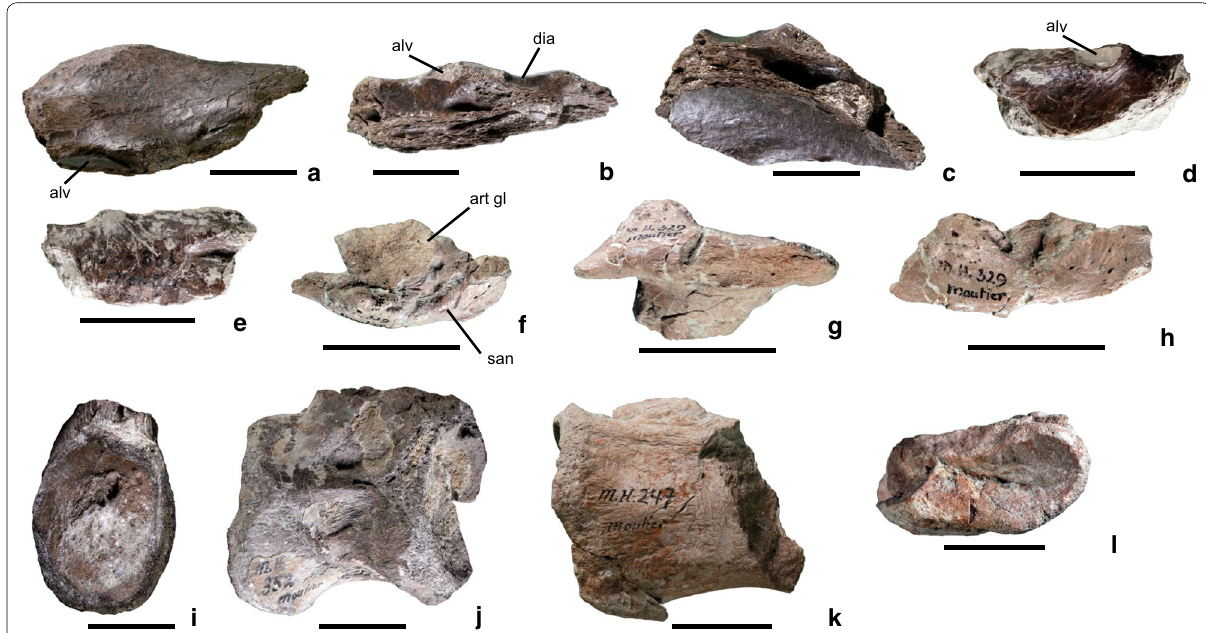
Fig. 16 Bone fragments of teleosaurid crocodylomorphs from Moutier. M.H. 370, incomplete left premaxilla in a dorsal, b lateral and c medioventral aspect. M.H. 303, fragment of right premaxilla in d ventral and e dorsal aspect. M.H. 329, fragment of a retroarticular process in f dorsal, g ventral and h lateral aspect. Dorsal vertebra M.H. 352, i in anterior, j in left lateral aspect. Caudal vertebra M.H. 247, k in posterior, l in ventral aspect. Scale bar is 30 mm. alv alveolus, art gl glenoid surface of articular bone, dia diastema, san